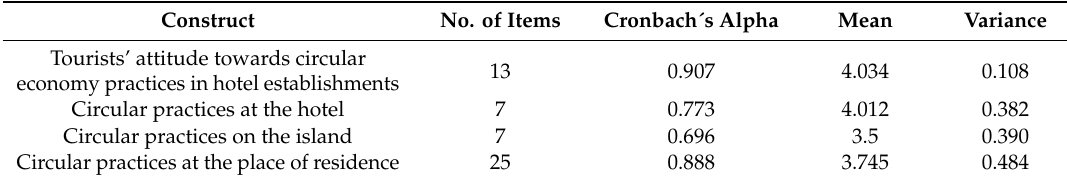
Table 3. Reliability analysis and descriptive statistics (N =